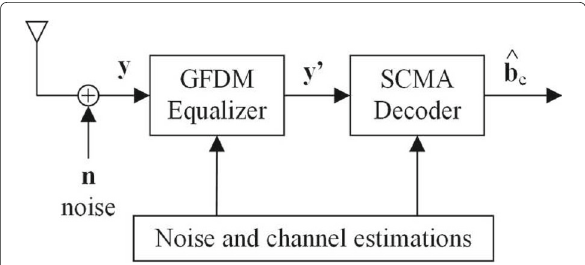
Fig. 6 Block diagram of the receiver of the multi-user SCMA-GFDM